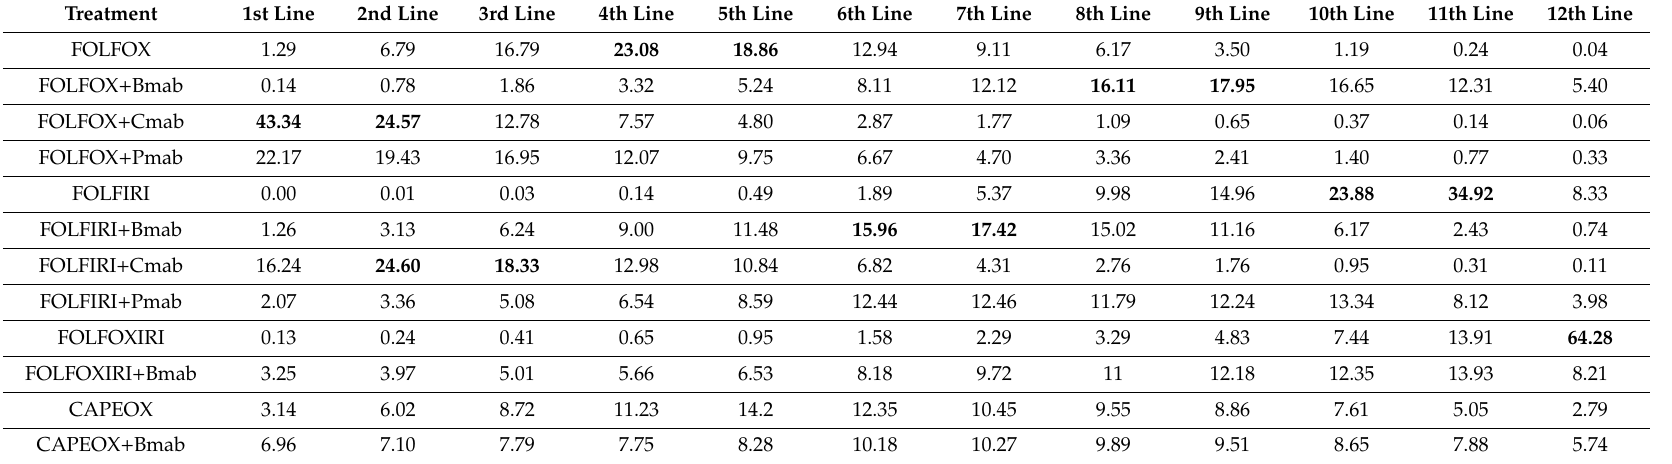
Table 5. Treatment ranking probability (%) for overall